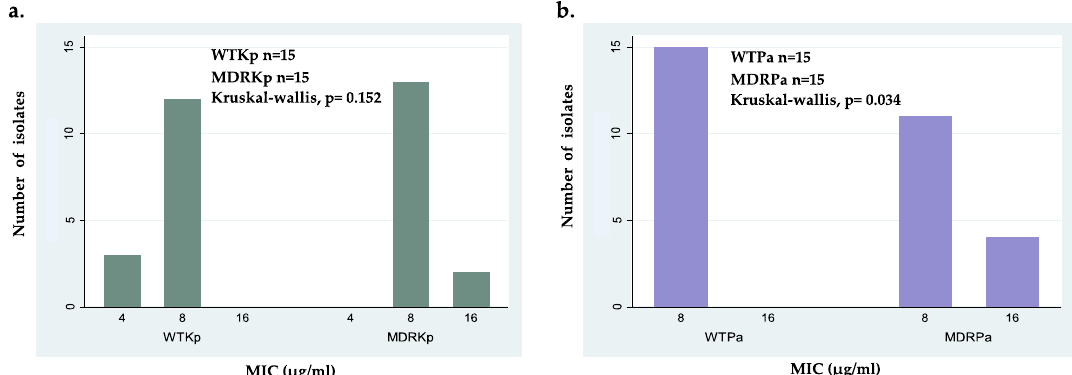
Figure 1. Minimal inhibitory concentration (MIC) distribution of ∆ M2 for: ( a ) wild-type isolates (WTPa) and multidrug- resistant isolates (MDRPa) of Pseudomonas aeruginosa ; ( b ) wild-type isolates (WTKp) and multidrug- resistant isolates (MDRKp) of Klebsiella pneumoniae.